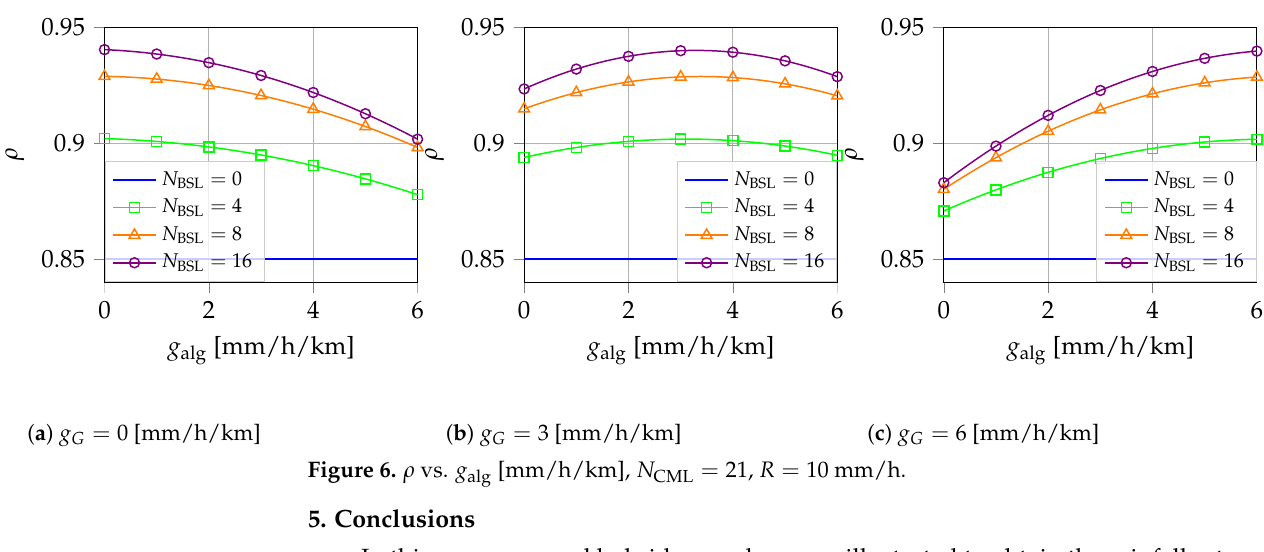
Figure 6. ρ vs. g alg [mm/h/km], N CML = 21, R = 10